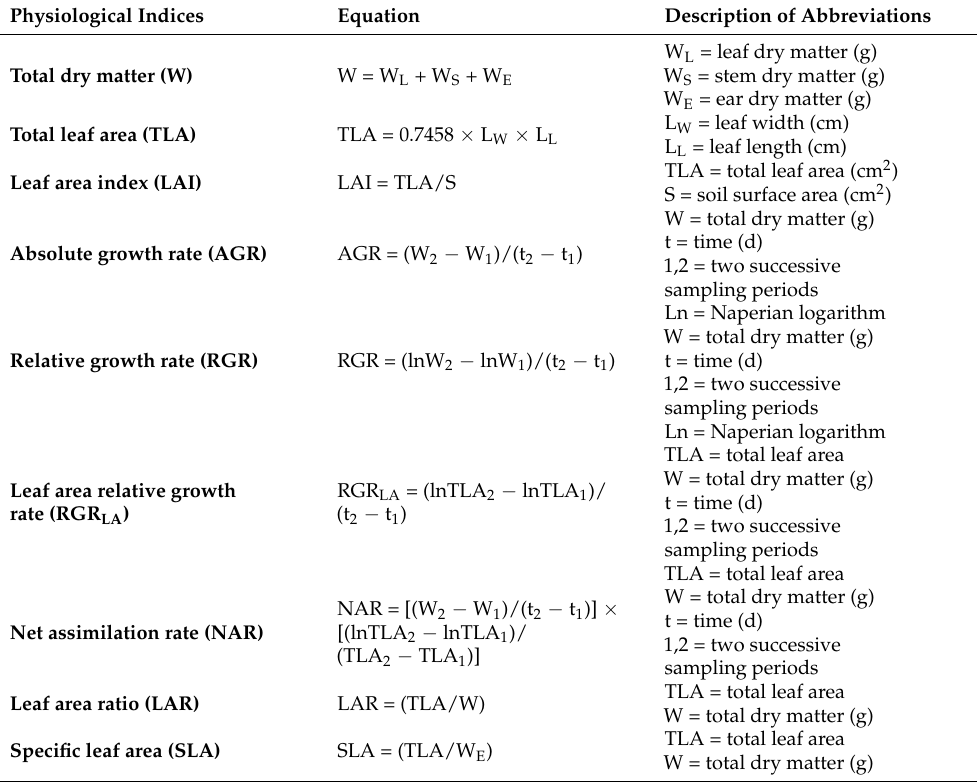
Table 5. Morphological and physiological parameters assessed in this study pertaining to maize growth and the respective equations used for their determination as described in Guimar ã es et al. [23] and in Benicasa